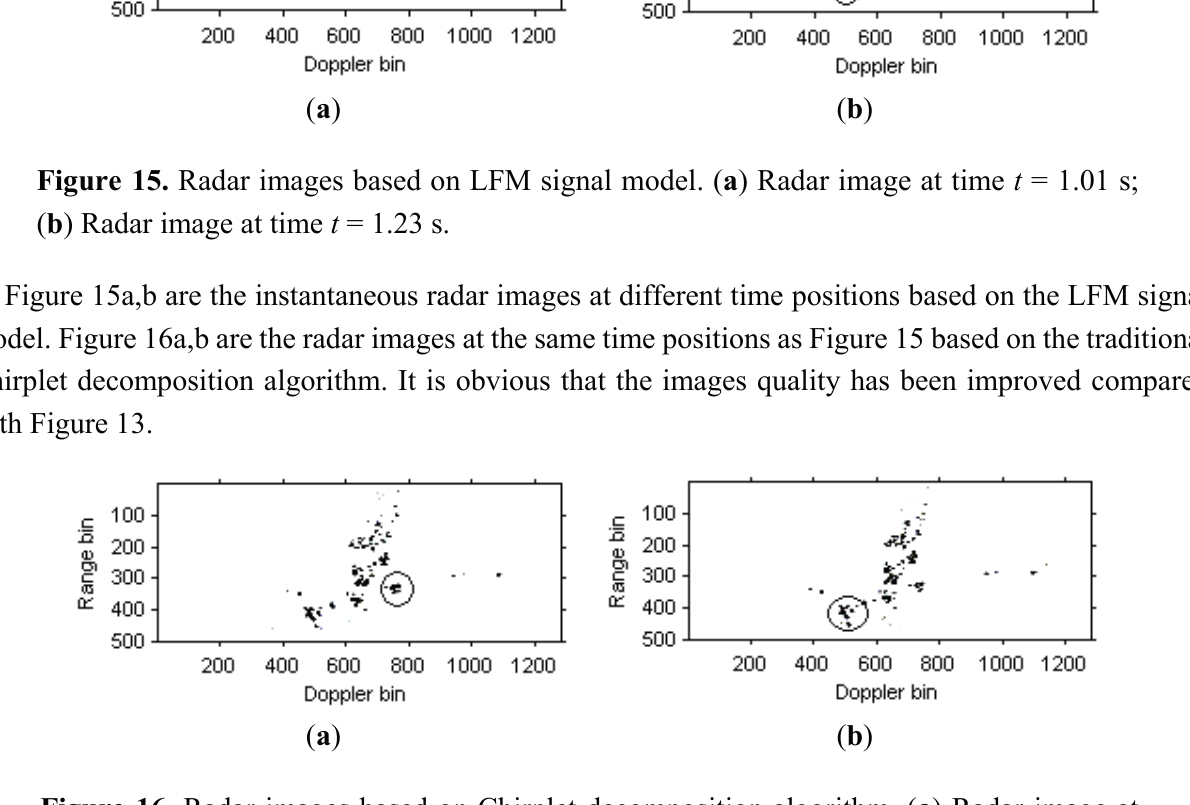
Figure 16. Radar images based on Chirplet decomposition algorithm. ( a ) Radar image at time t = 1.01 s; ( b ) Radar image at time t = 1.23